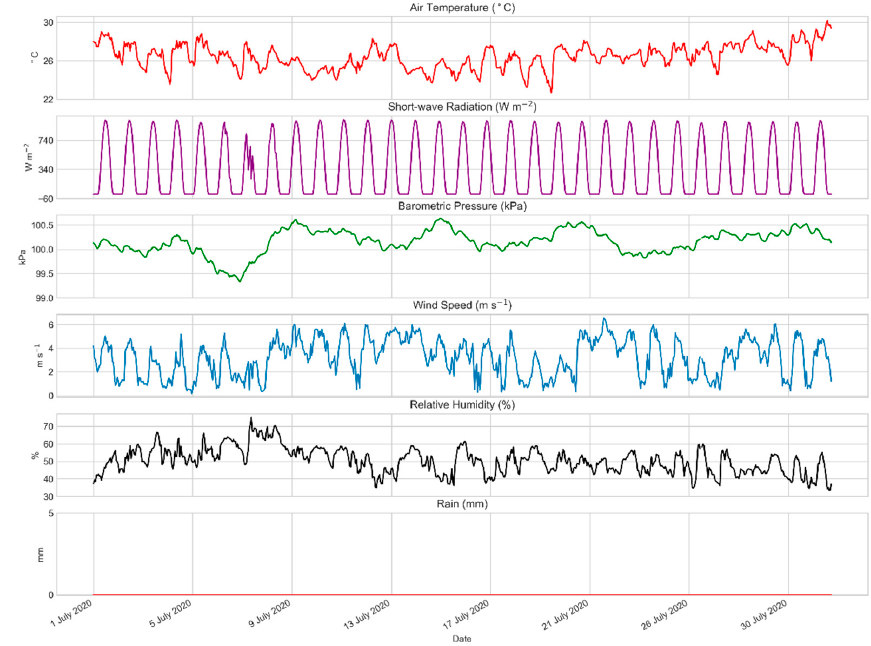
Figure 4. Forcing data for July 2020.